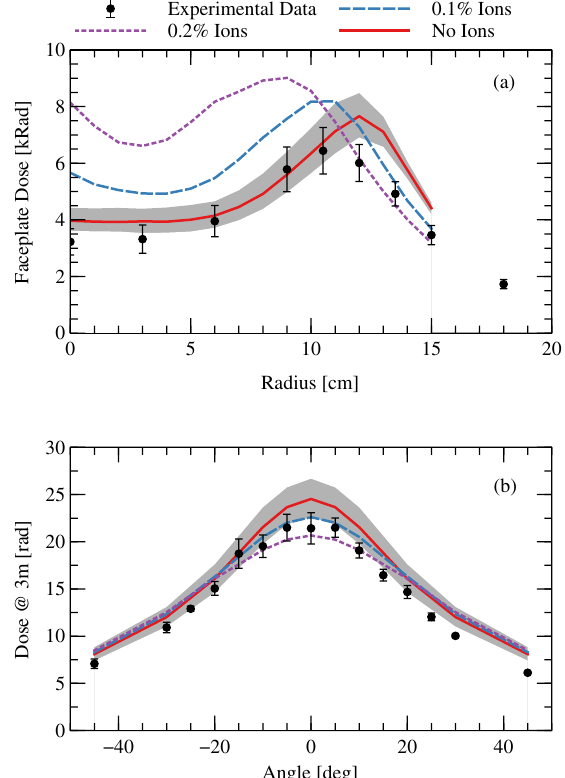
FIG. 11. Comparison of measured (points) and simulated (curves) doses from simulation Case 0 and Cases D1 – D2, in (a) the near field and (b) the far field. The effects of stimulated ion emission on the computed doses are: (a) the radial location of the peak dose moves inward with increasing ion emission, and an on- axis peak in dose starts to form, and (b) the far-field dose distribution is suppressed on axis with increasing ion emission.